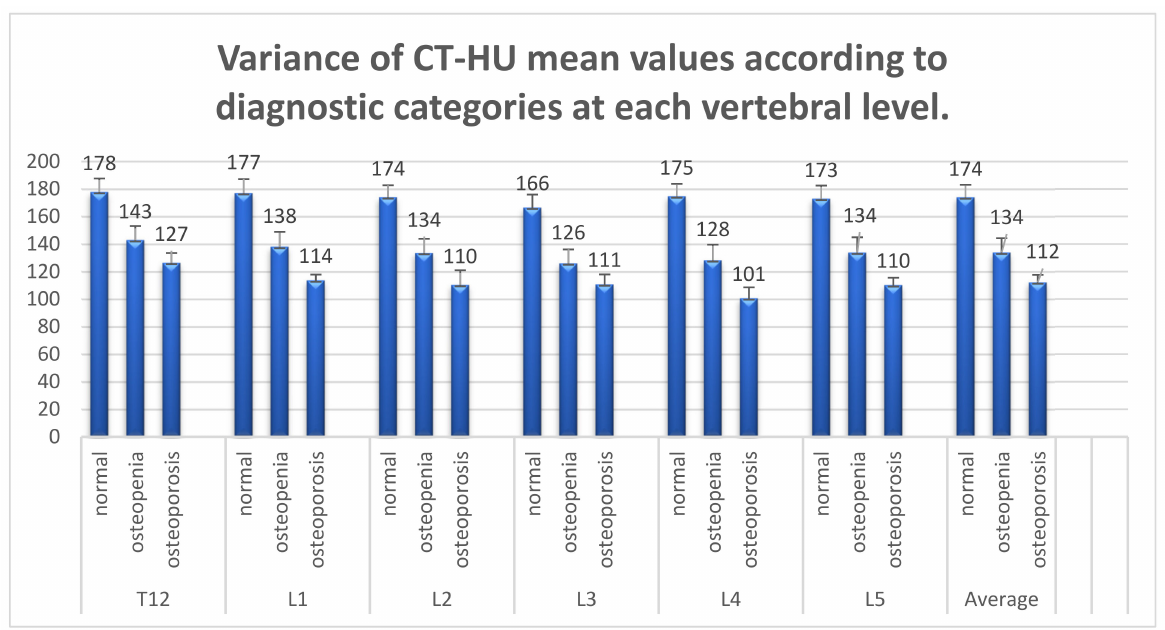
Figure 2. Variance in the mean CT-HU according to DXA diagnostic categories at each vertebral